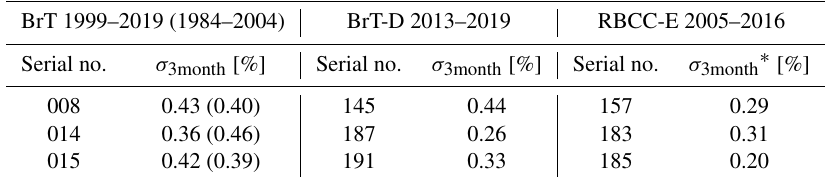
Table 6. Brewer reference instruments vs. MERRA-2 reanalysis ozone dataset. Brewer serial SBUV-based MLS/OMI-based no. (cid:49) (cid:48) M-Bias ∗ σ 1month (cid:49) (cid:48) M-Bias ∗ σ 1month rel rel [%] [%] [%] [%] [%] [%] 008 − 0 . 13 − 0 . 27 1.14 0.61 014 0.11 145 N/A N/A N/A 187 N/A N/A